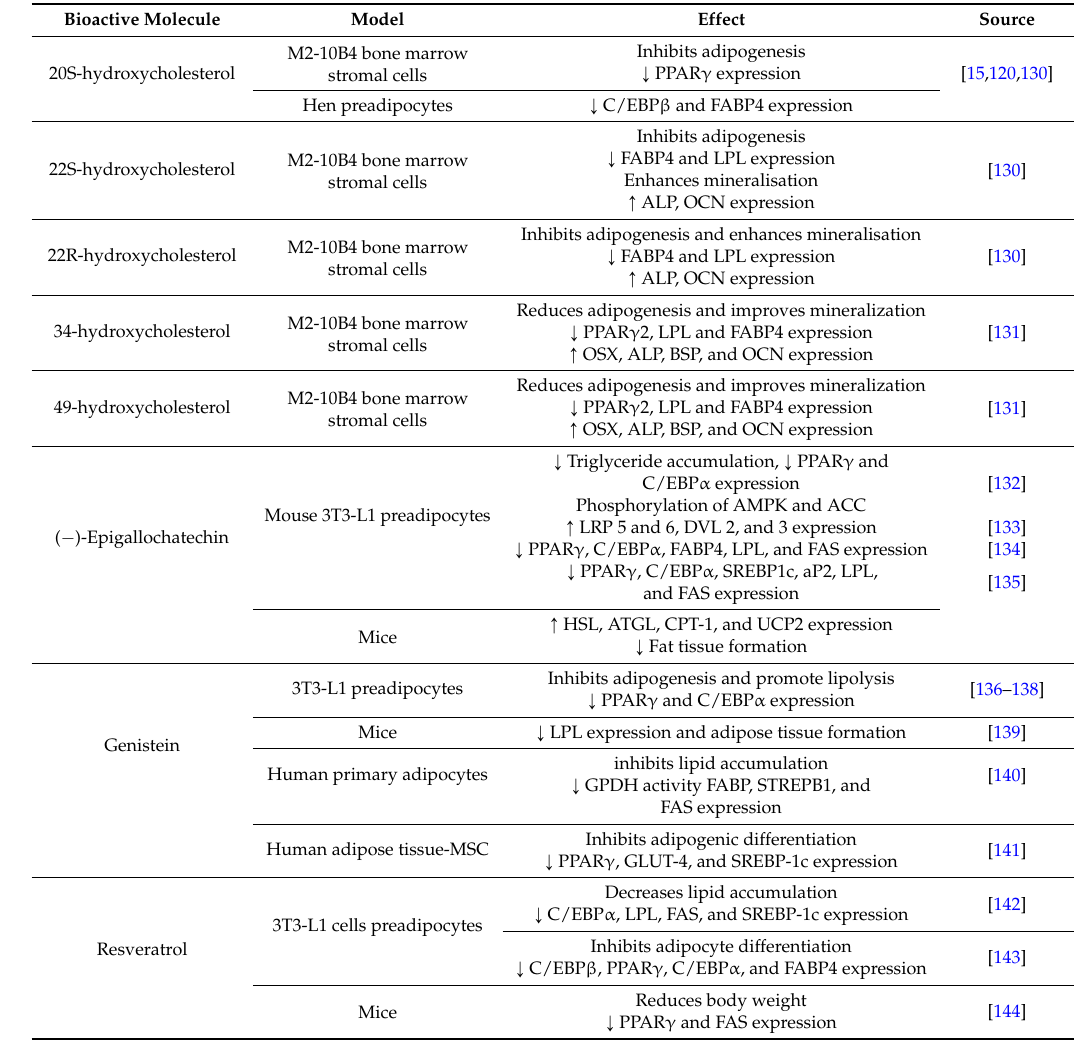
Table 2. Bioactive molecules potentially inhibiting adipogenic differentiation and enhancing osteogenic differentiation in animal and cell culture